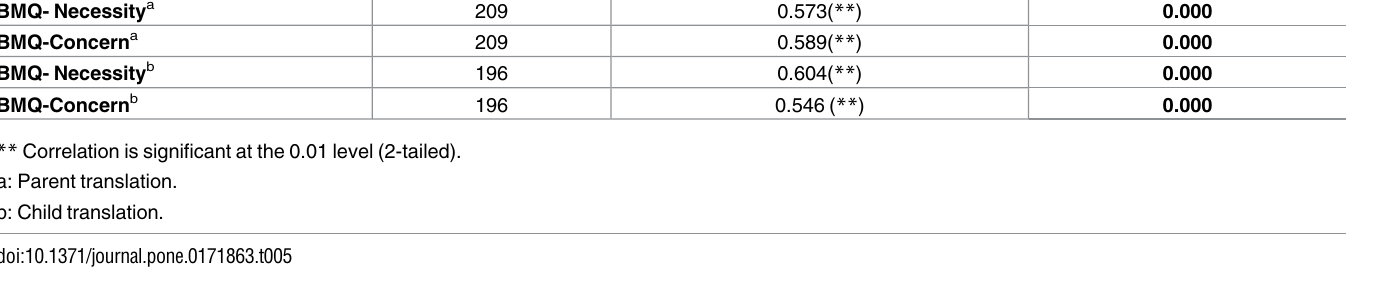
Table 5. Pearson Product Moment Correlation between MARS, BMQ-specific at Time 1 and Time 2. Items N Pearson correlation